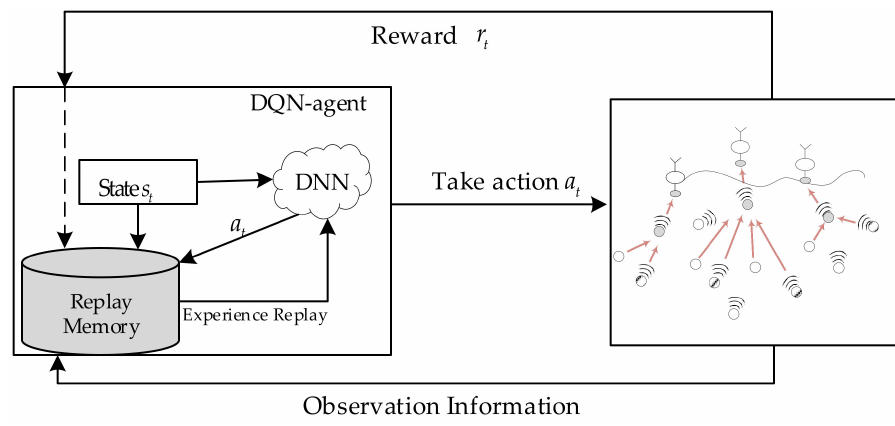
Figure 4. Deep Q network for the OA-DLMA protocol of UWSNs. The learning and training process of OA-DLMA is described in Algorithm 1. Algorithm 1: Training process of the OA-DLMA protocol for heterogeneous